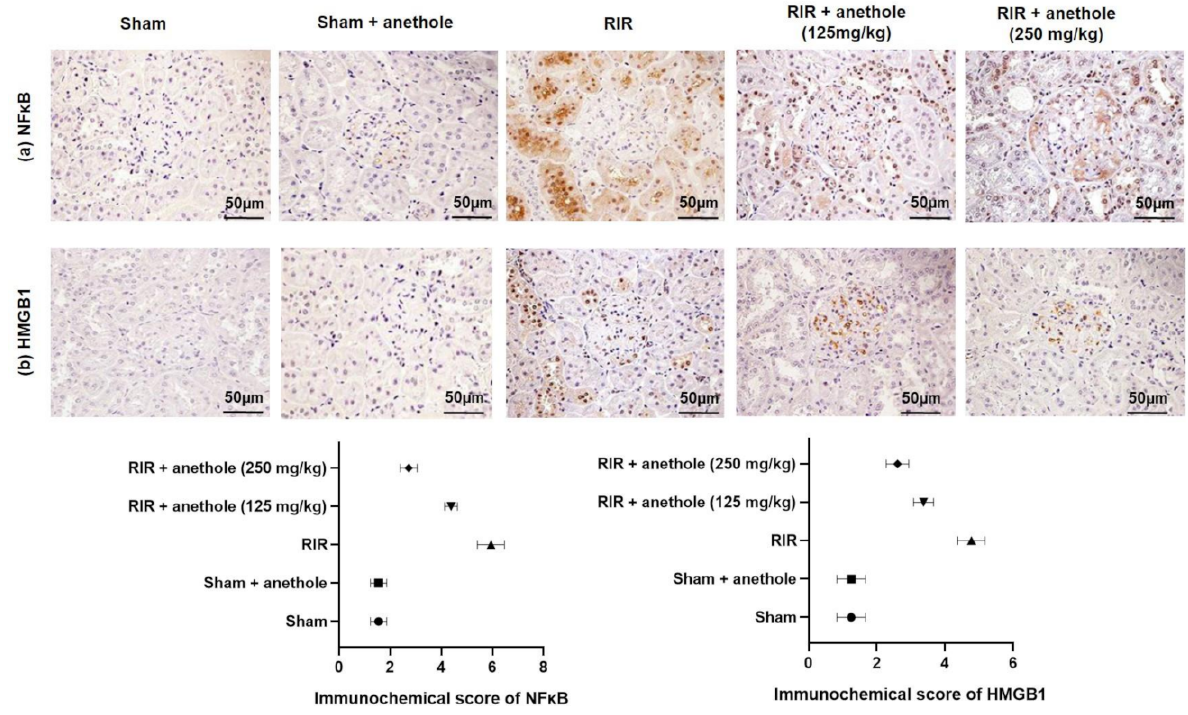
Figure 6. Effects of anethole (125 and 250 mg/kg) administration for 14 days prior to renal is- chemia/perfusion (RIR) on the renal immunohistochemical assay of ( a ) NF κ B and ( b ) HMGB1 in RIR-induced injury. All values are stated as mean ± SD.